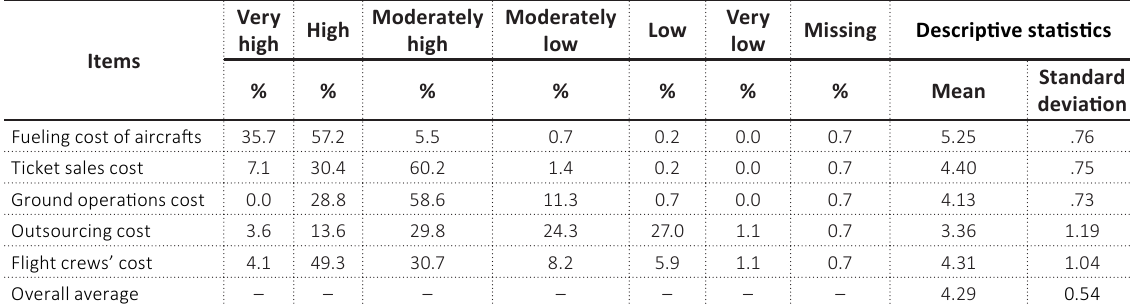
Source: Field survey result